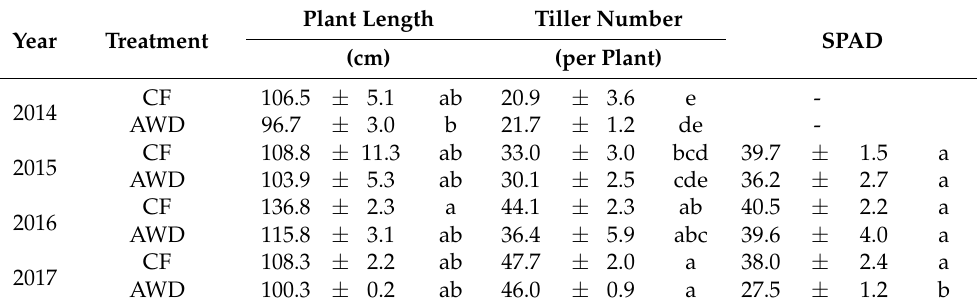
Table 2. Plant length, number of tillers, and Soil Plant Analysis Development (SPAD) values at heading stage in Basmati 370 rice plants, grown under continuous flooding (CF) and alternate wetting and drying (AWD) conditions, during the 2014, 2015, 2016, and 2017 season.